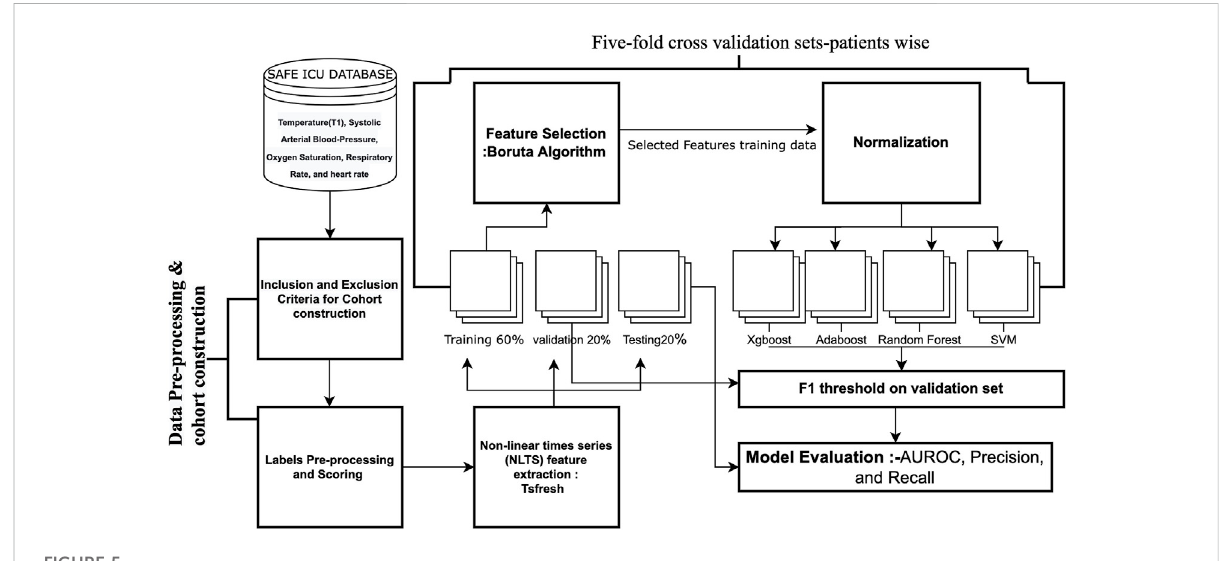
FIGURE 5 Overview of ThermoGnose